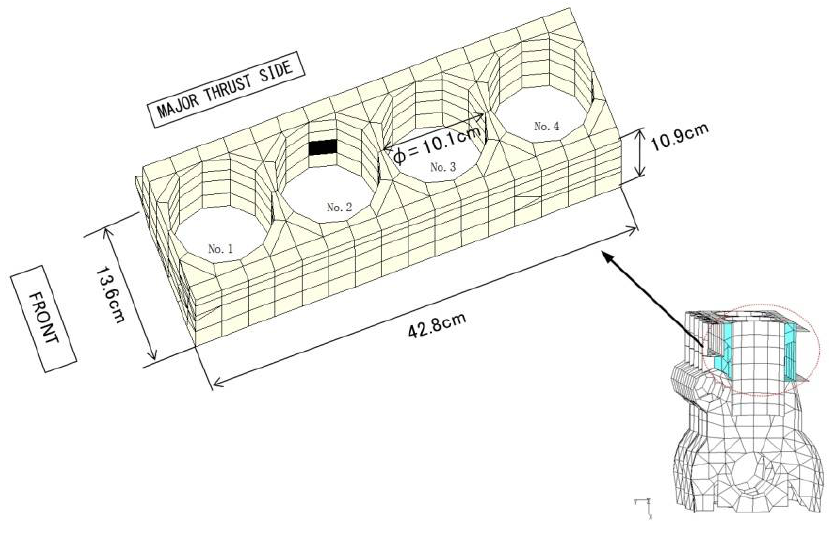
Figure 9. Acoustic characteristics of water jacket model. In order to further quantify the nature of the water jacket acoustic model, a theoret- ical rectangular acoustic model is analyzed and compared with the water jacket model. The n-th order of wavenumber k (cid:2924) and natural frequency f (cid:2924) of a rectangular acoustic model with length l (cid:2869) , width l (cid:2870) and height l (cid:2871) can be obtained as follows: k (cid:2924) = (cid:3495)(cid:3435)k (cid:2869) (cid:3171)(cid:3117) (cid:3439) (cid:2870) + (cid:3435)k (cid:2870) (cid:3171)(cid:3118) (cid:3439) (cid:2870) + (cid:3435)k (cid:2871) (cid:3171)(cid:3119) (cid:3439) (cid:2870) , f (cid:2924) = k (cid:2924) c 2π